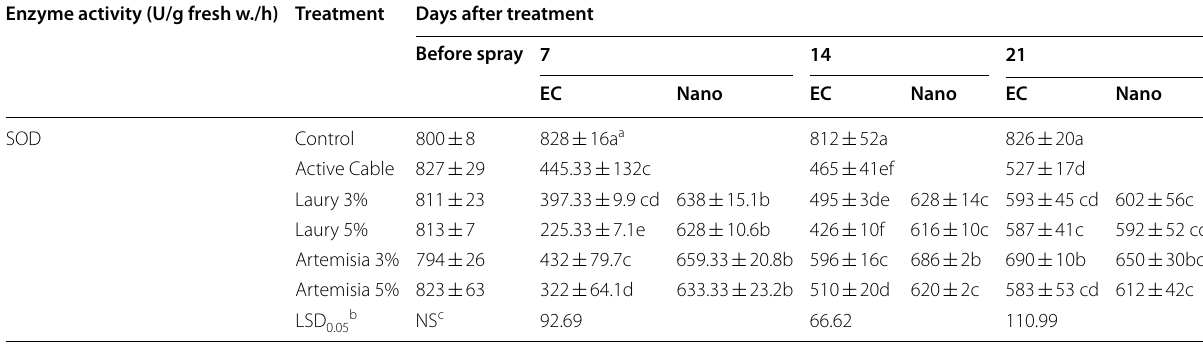
Each value represents the mean of three replicates a Means with different letters within each interval were significantly different at the 0.05 level (Duncan’s multiple range test) b Least significant difference at 0.05 level of probability c Non‑significant difference at 0.05 level